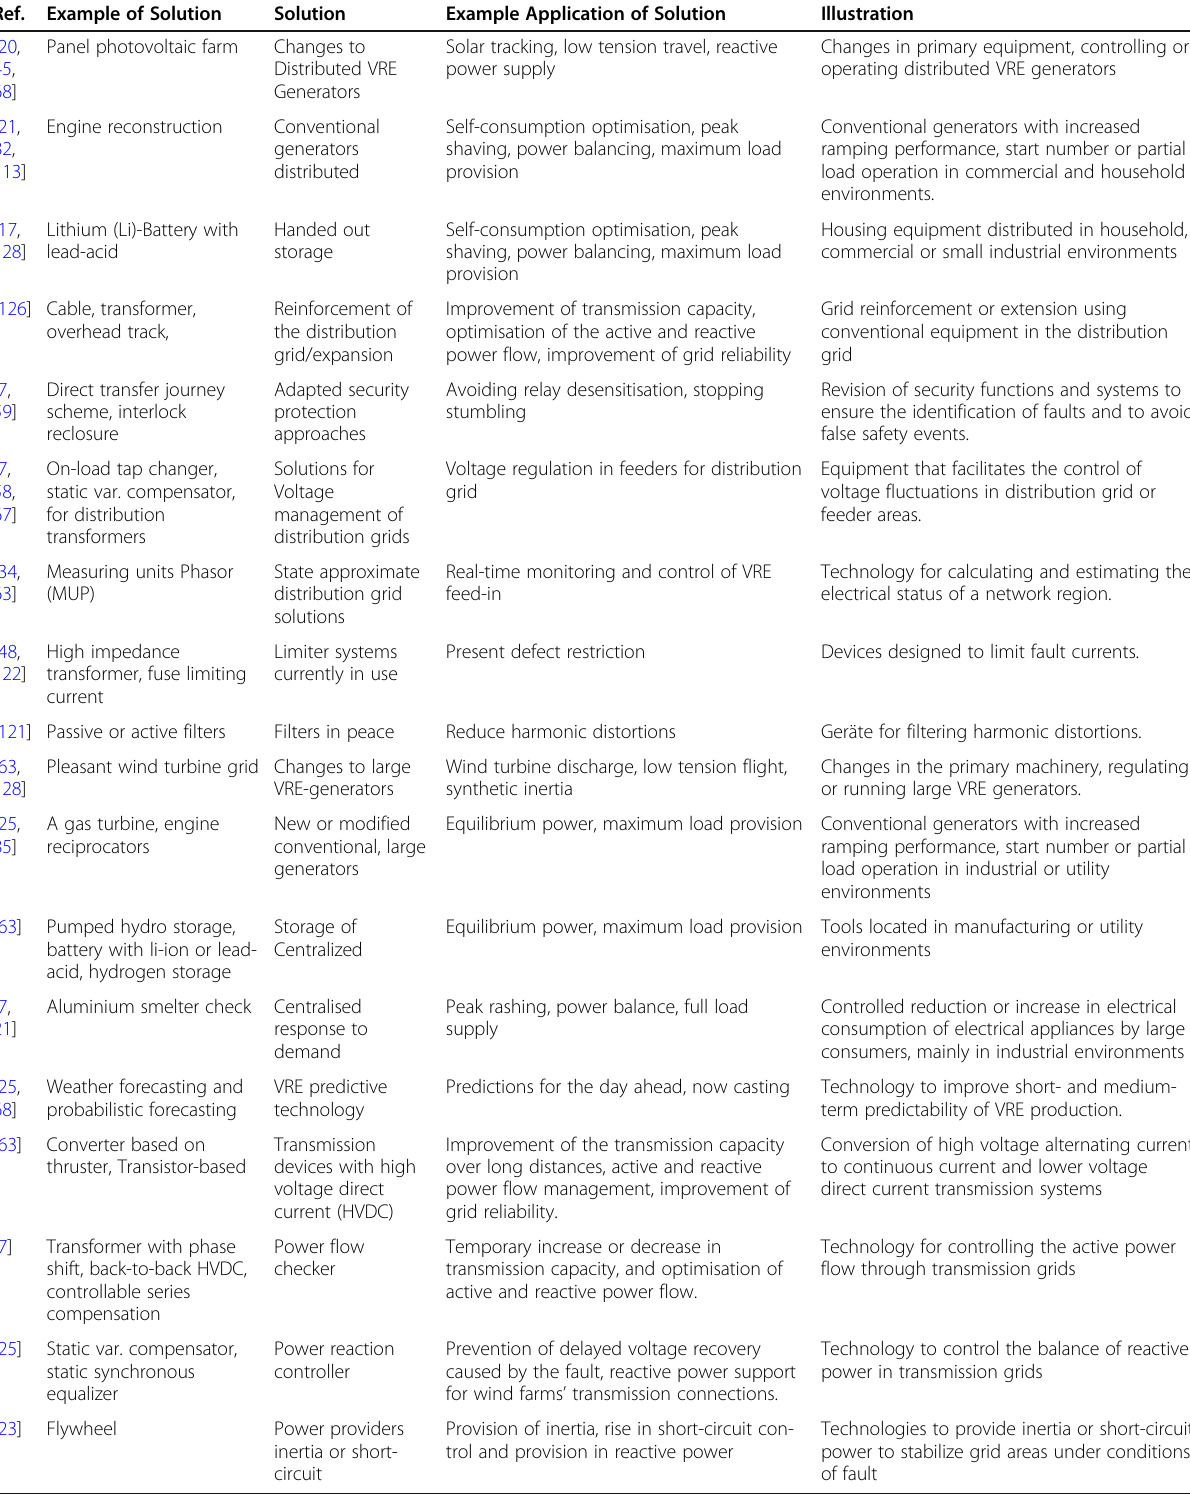
Table 4 Solution VRE integration